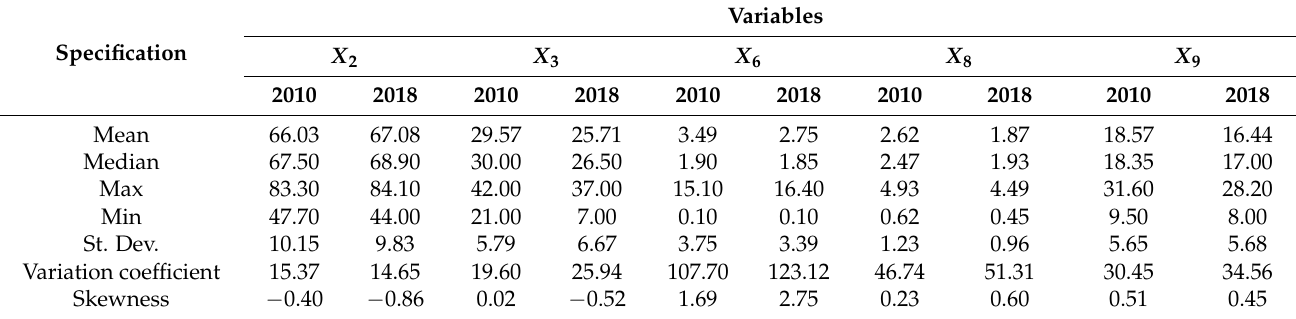
Table 2. Values of descriptive parameters in 2010 and 2018 regarding indicators defined in SDG3.